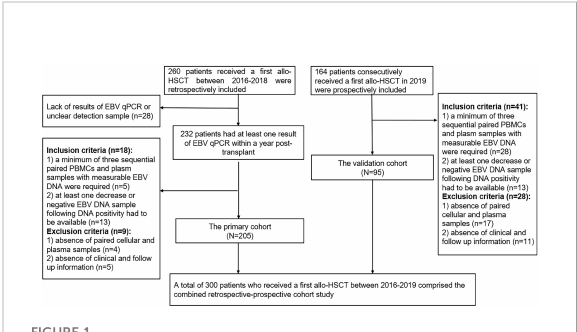
FIGURE 1 Flow diagram of patient specimens included in the